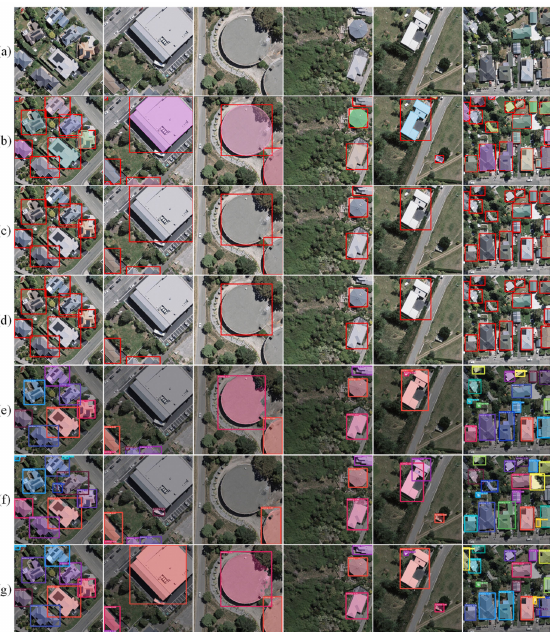
Figure 8. Results of building detection on the RSIBE dataset. ( a ) Images. ( b ) Labels. ( c ) YOLOv4.